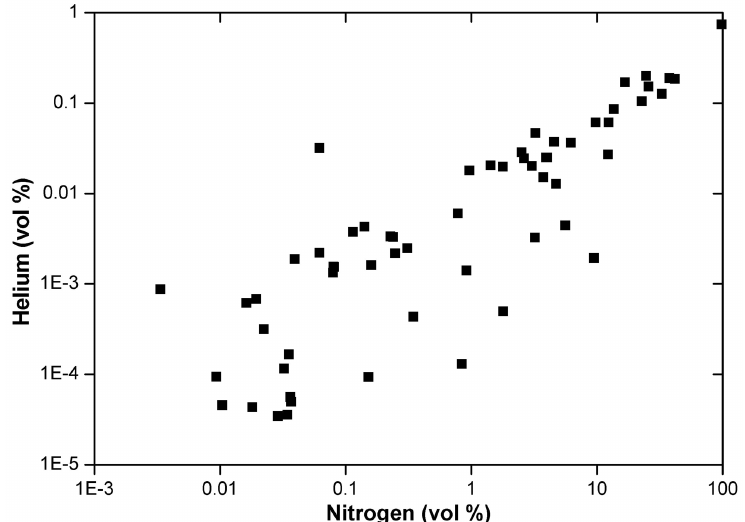
Fig. 7. Correlation between nitrogen and helium contents in gases of the western Eger Rift (data from Wein- lich et al .,